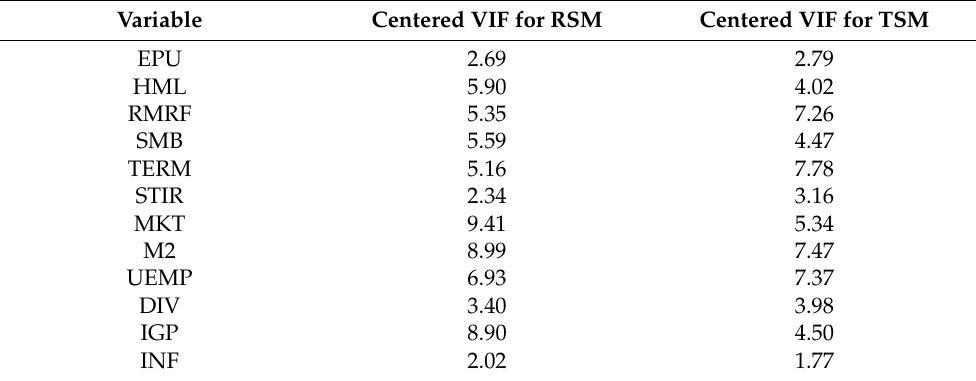
Table 8. Centered VIF for RSM and TSM returns with selected macroeconomic variables. Variable Centered VIF for RSM Centered VIF for